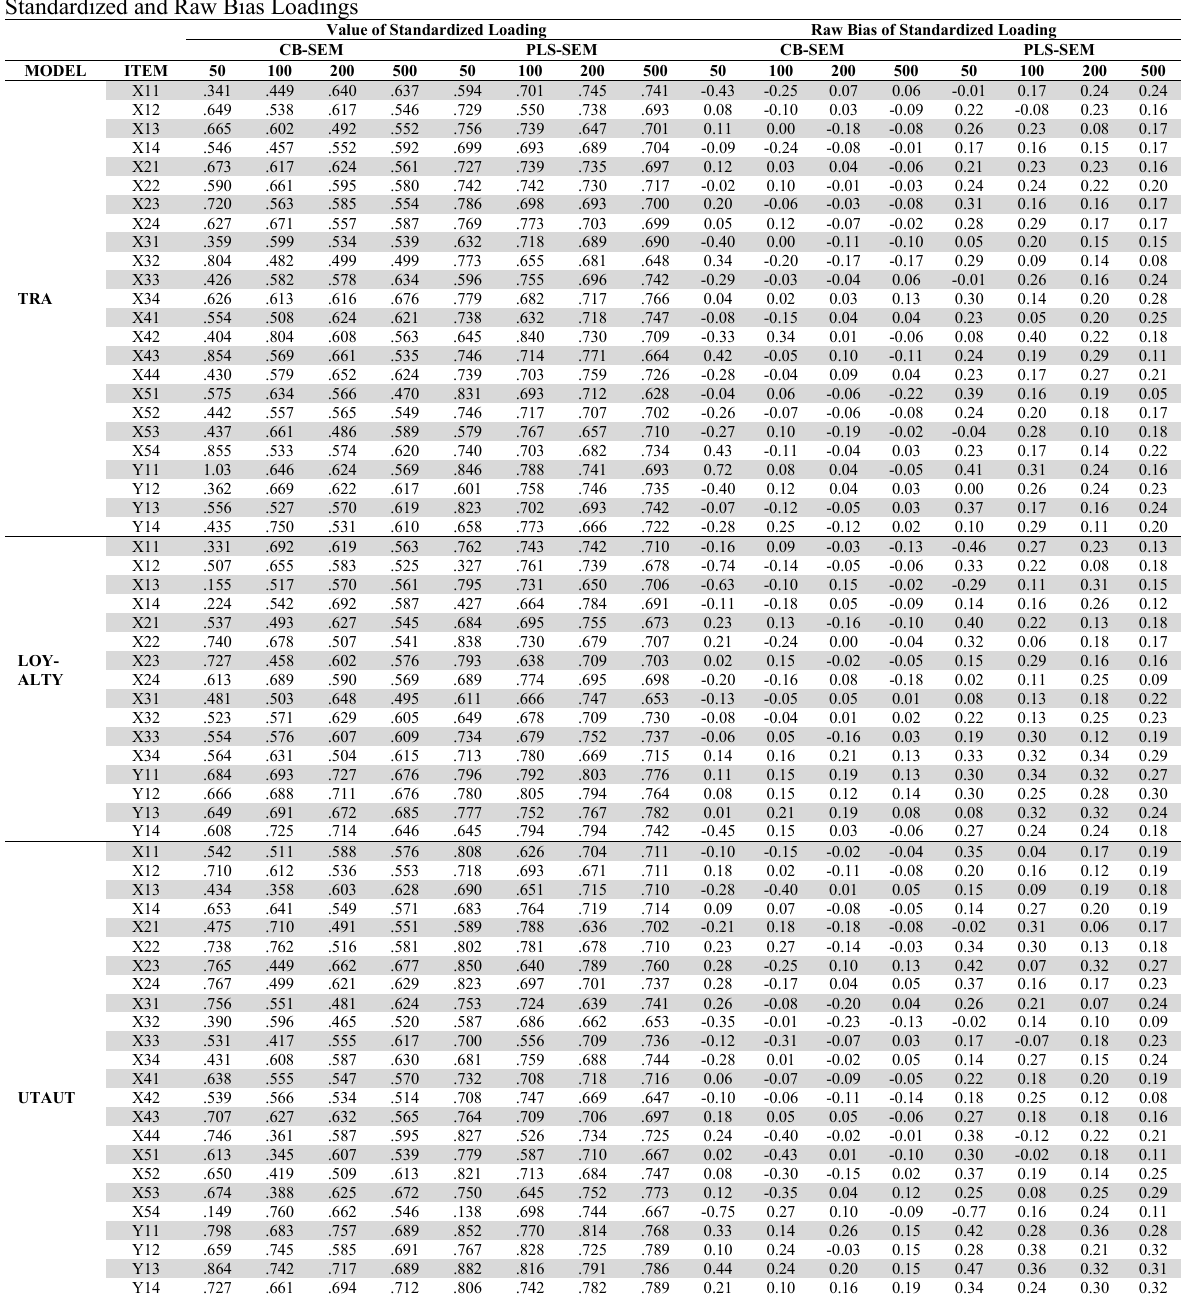
Table 1 Standardized and Raw Bias Loadings